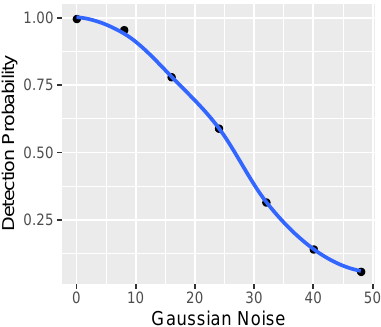
Figure 7. Face recognition detection [probability] for recognition defocus [ σ /pixels].